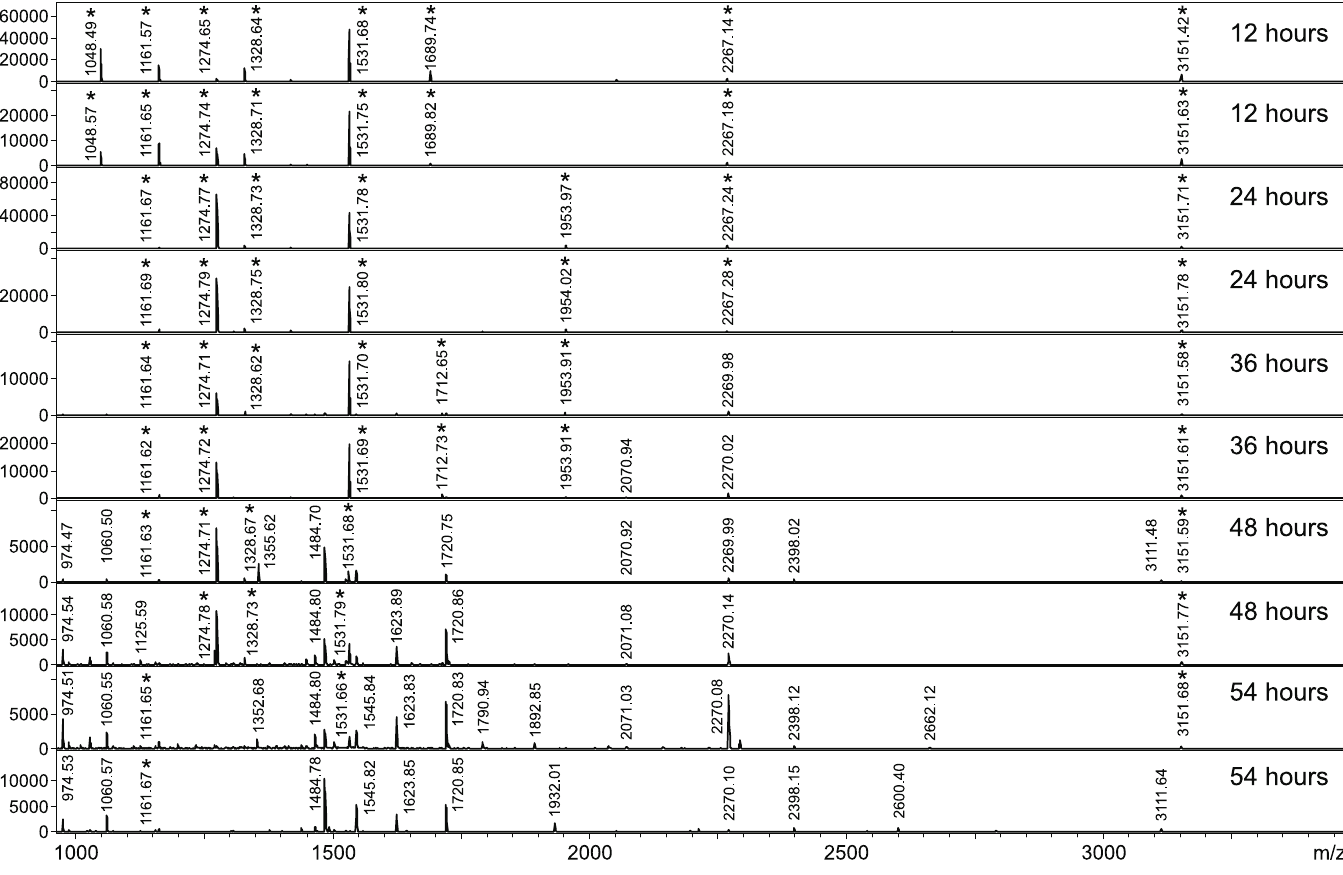
Fig 5. Abdominal peptide mass spectra of P . orientalis females at different time points after blood feeding on rabbit. The peptide signals of rabbit hemoglobin are marked by asterisks. The peaks related to digestion of sand fly body become obvious since 48h PBM. For each time point the spectra of two females are presented.